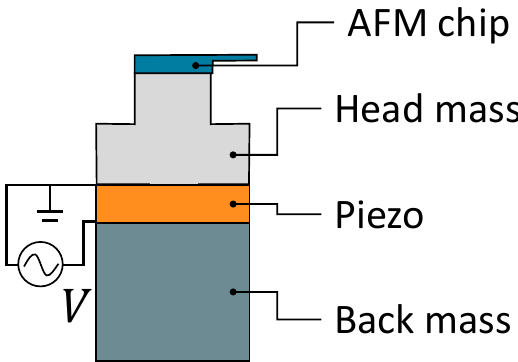
Figure 1. Schematic representation of the elementary components of a Langevin transducer, consisting of a head mass, a piezoelectric element, and a back